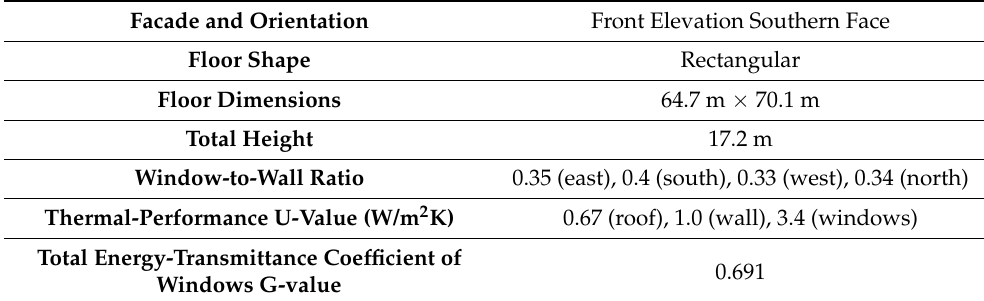
Table 1. Basic building characteristics of the SEB.